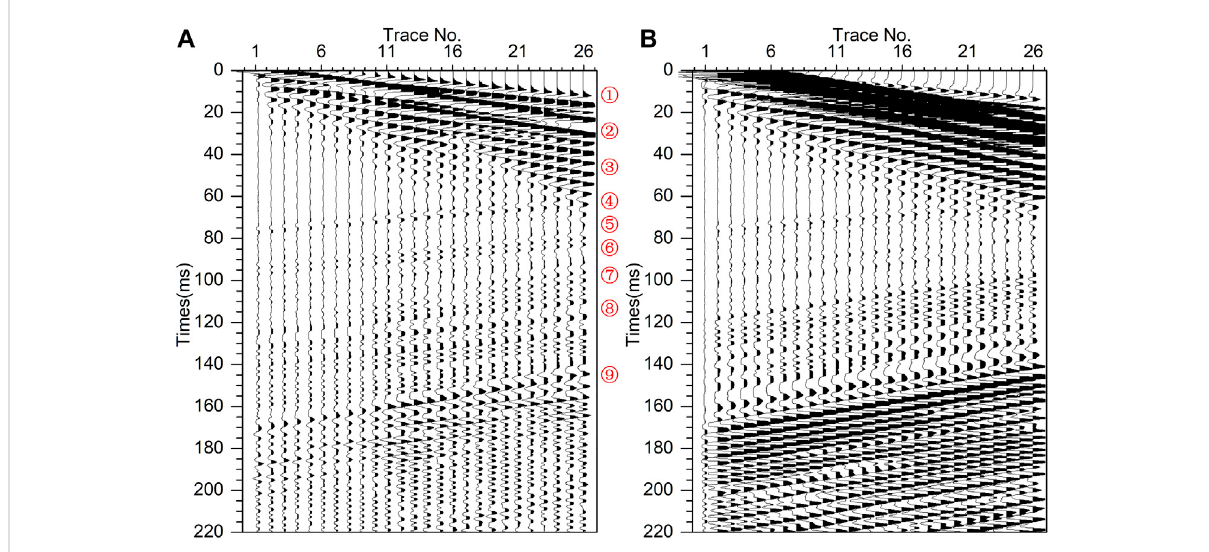
FIGURE 11 Synthetic records of the advanced faulted coal seam model. (A) X-component; (B) Z-component.